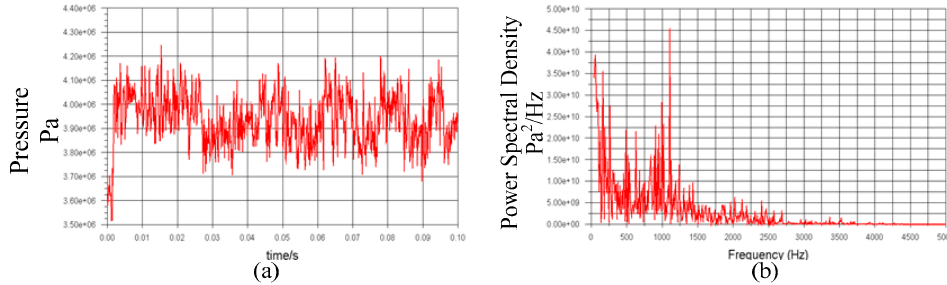
Figure 21. Pressure oscillation curve of the flapper considering the impression of the main valve and velocity of 25 m/s. ( a ) Time domain. ( b ) Frequency domain.